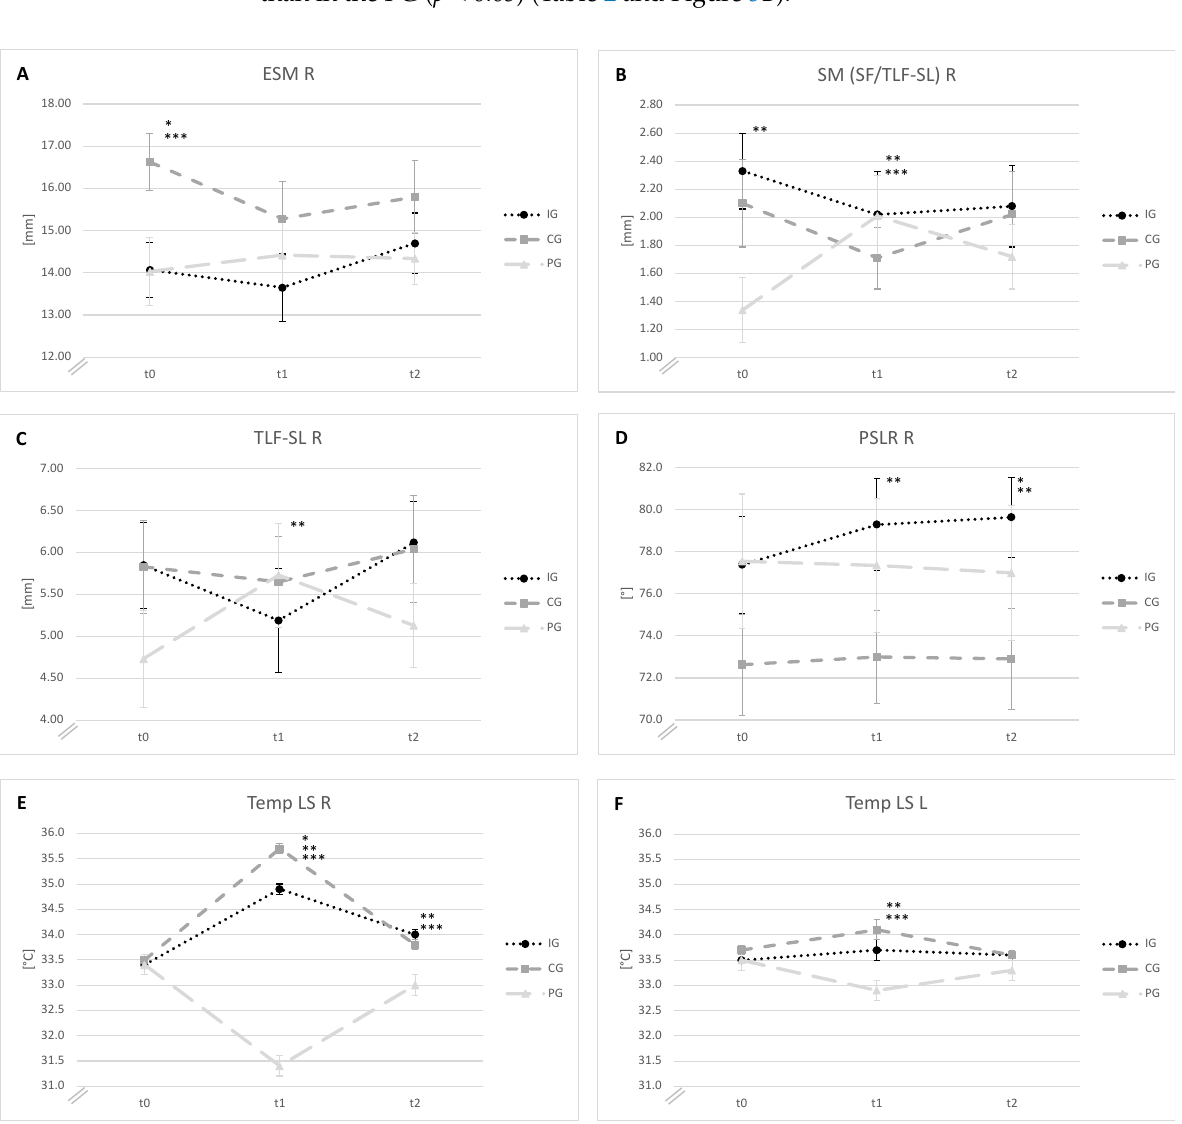
Figure 5. ( A ) Absolute movement of the paravertebral muscles on the right side of the lumbar spine (ESM R) in millimetres. ( B ) Shear motion between the superficial fascia and the superficial lamina of the thoracolumbar fascia on the right side (SM (SF/TLF ‐ SL) R) in millimetres. ( C ) Absolute move ‐ ment of the superficial lamina of the thoracolumbar fascia on the right side of the lumbar spine (TLF ‐ SL R) in millimetres. ( D ) Passive straight leg raise test to determine hamstring flexibility on the intervention side (PSLR R) in degrees. ( E ) Superficial skin temperature of the intervention area (Temp LS R) in degrees Celsius. ( F ) Superficial skin temperature of the control side (Temp LS L) in degrees Celsius. The mean values ±SE at the three measurement time points (t0: before the interven ‐ tion; t1: immediately after the intervention; t2: 45 min after the intervention) are shown. p < 0.05 * IG vs. CG, ** IG vs. PG, *** CG vs. PG. IG: intervention group; CG: comparison group; PG: placebo group. The baseline functional movement parameters did not differ between the groups (Ta ‐ ble 3). The PSLR on the intervention side showed an improved ROM in the IG compared with that in the PG immediately after the intervention ( p < 0.05) (Table 3 and Figure 5D).